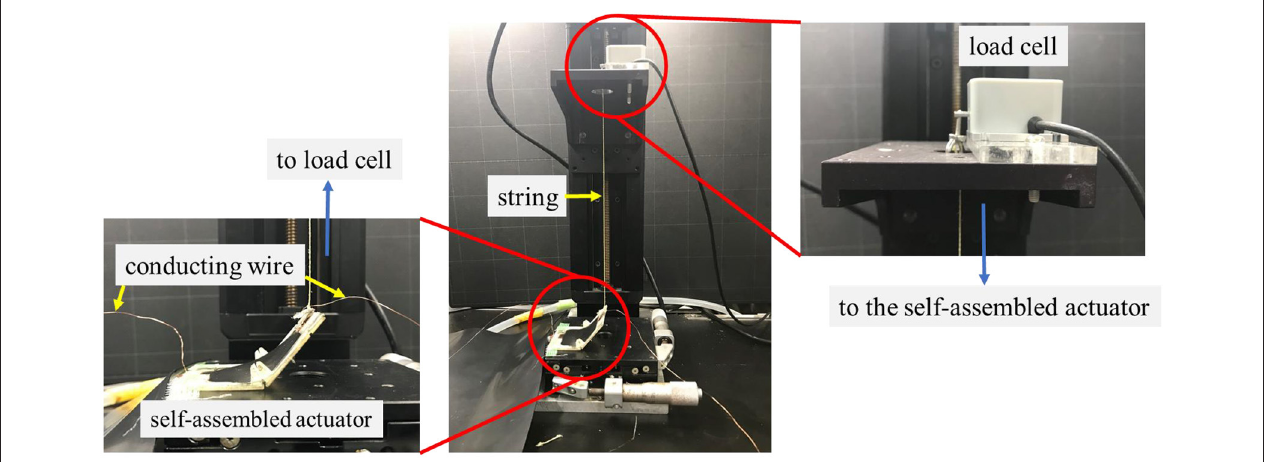
TABLE 3 | Measurement results of the force generated by the actuator.